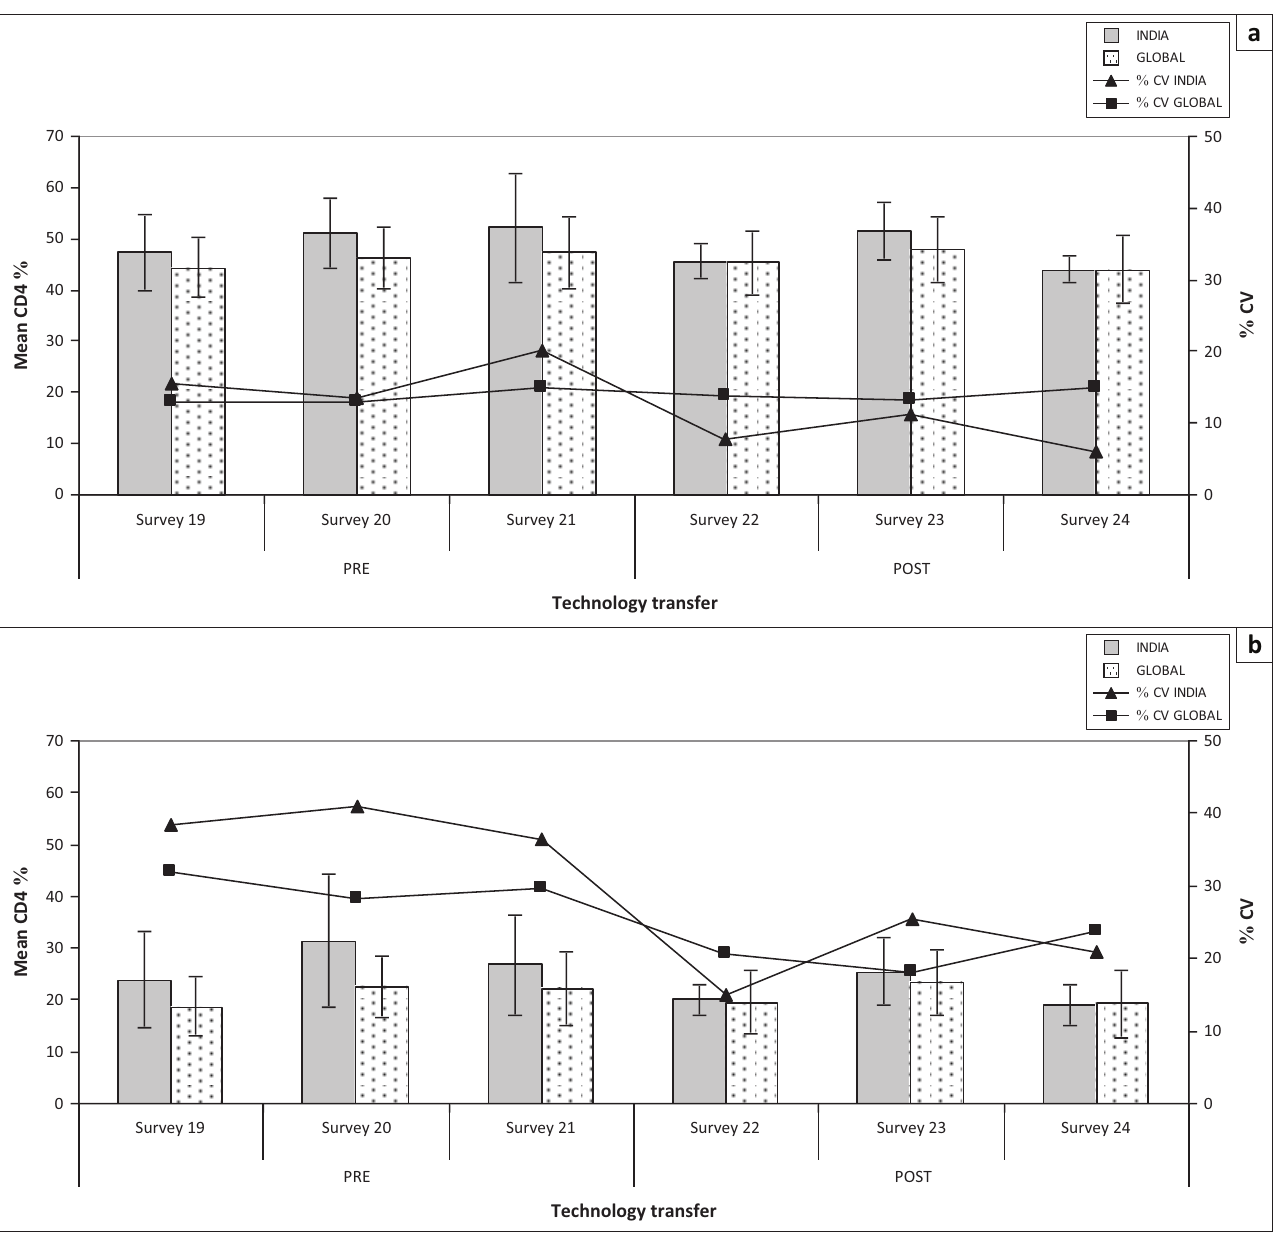
FIGURE 2: Pre- vs post-transfer national and global CD4 percentage performance. Comparison of national and global performance across six consecutive surveys reflecting the impact of technology transfer provided by both QASI and NARI between surveys 21 and 22. Pre-technology transfer reflects QASI sessions 19 through 21 (October 2008, February 2009, June 2009). QASI advanced workshop training was held in September 2009 at NARI in Pune, India. Post-technology transfer reflects QASI sessions 22 through 24 (October 2009, February 2010, June 2010). Group mean CD4 lymphocyte percentages, standard deviation (error bars) and % CV are illustrated for mid-level (a) and low-level (b) CD4 count controls. Note the drop in % CV for India from 16.4 % to 8.3 % (a) and from 38.6 % to 20.4 %